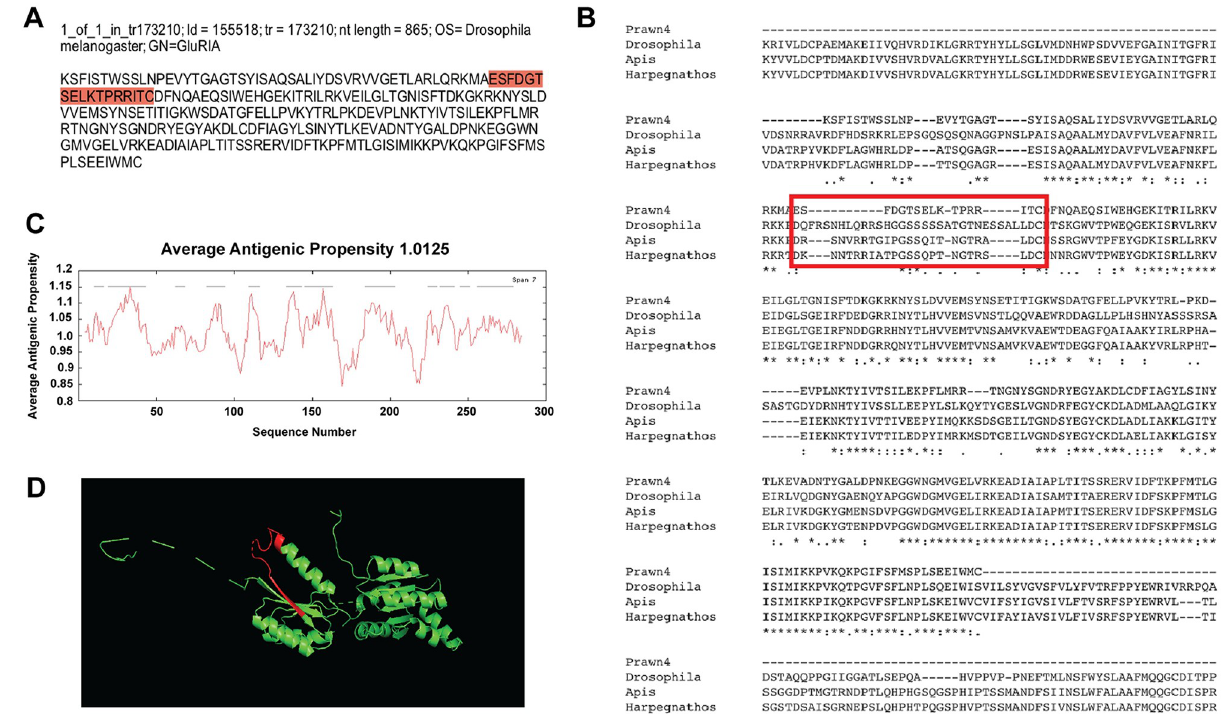
Fig 6. Contig annotated as ionotropic glutamate receptor A-2 (GluRIA-2) analysis for antibody production. A) Contig identifiers for GluRIA-2 in the M . carcinus transcriptome and its sequence translated into amino acids for further analysis. B) Multiple sequence alignments of the prawn´s contig compared to the same protein in other species: the fruit fly D . melanogaster , European bee A . mellifera , and the Indian jumping ant H . saltator . Regions of conserved amino acids are shown within the red box. C) Average antigenic propensity value was 1.0125, showing 12 determinants (peaks in graph) within the sequence that are good candidates for antigenic response. D) A 3D reconstruction model showing tertiary structures of the prawn GluRIA-2 contig sequence. The red highlight in A, rectangle in B and segment in D represent the selected sequence for antibody production.